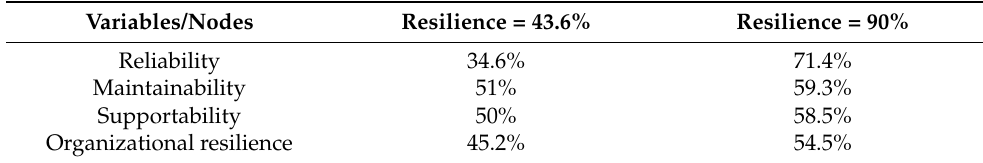
Figure 8. Backward propagation scenario when the expected resilience is set at 90%. Table 5. Enhancement of variables when enhancing resilience under Arctic black swan